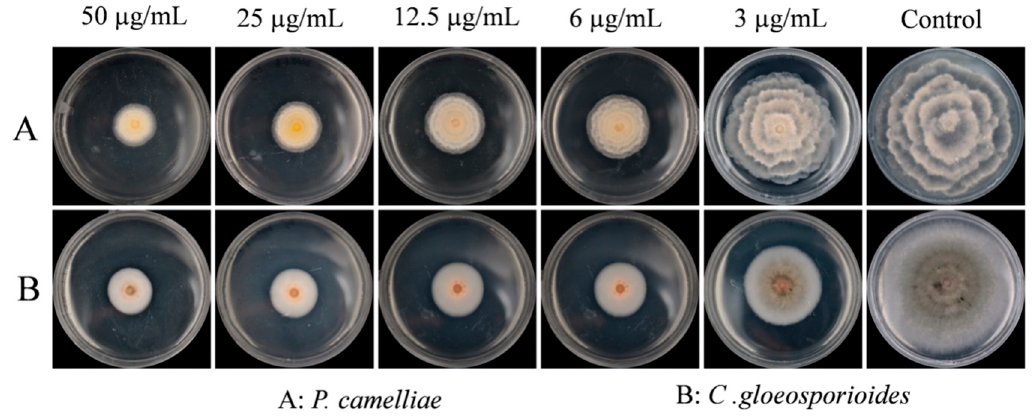
Figure 2. The mycelial growth of P. camelliae ( A ) and C. gloeosporioides ( B ) on different concentration of toxic potato dextrose agar medium (PDA) medium after 7 days.